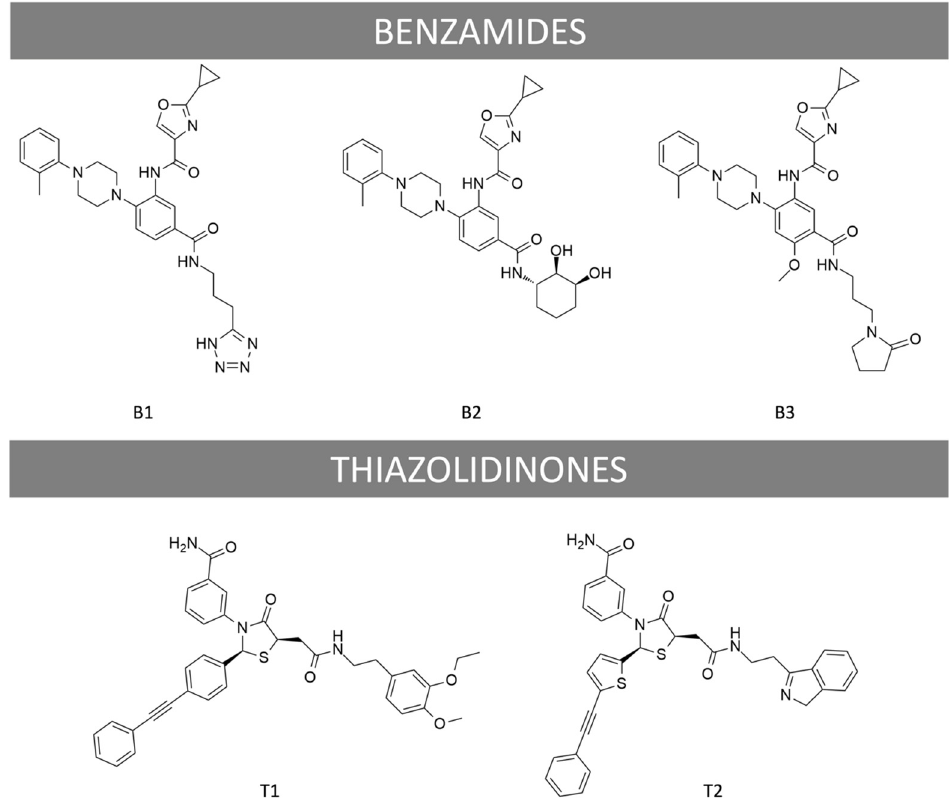
Figure 1. Chemical structures of LMW ligands used in the study. B1, B2, B3 are Benzamide derivatives; T1 is a Thiazolidinone derivative, and T2 is an antagonist obtained by chemically modifying T1.